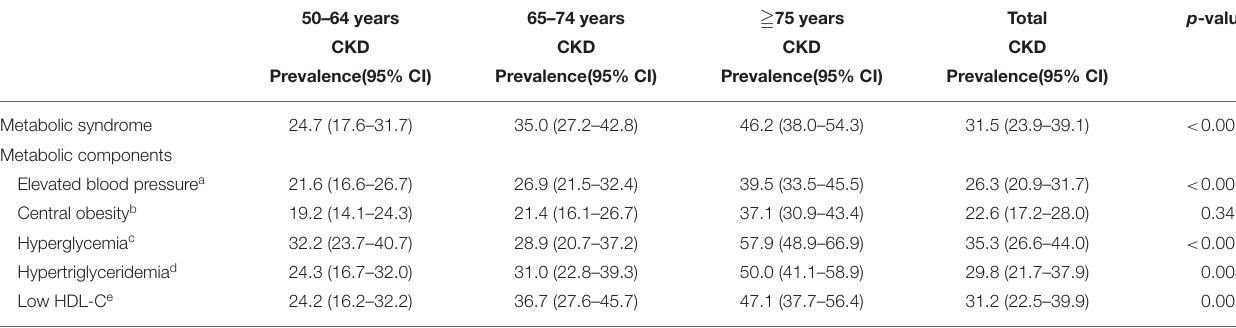
TABLE 2 | Associations between metabolic risk factors and chronic kidney disease in subjects by age group.